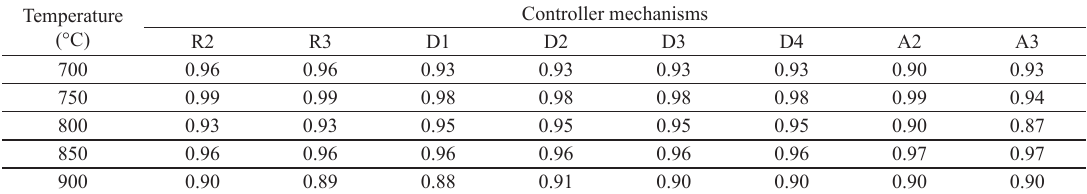
Table 6. Linear trend ( R 2 ) of the relationship between ln dα/dt vs. ln f(α) for the kinetic models for gas–solid reaction presented in Table 3 for each investigated temperature. Temperature (°C)